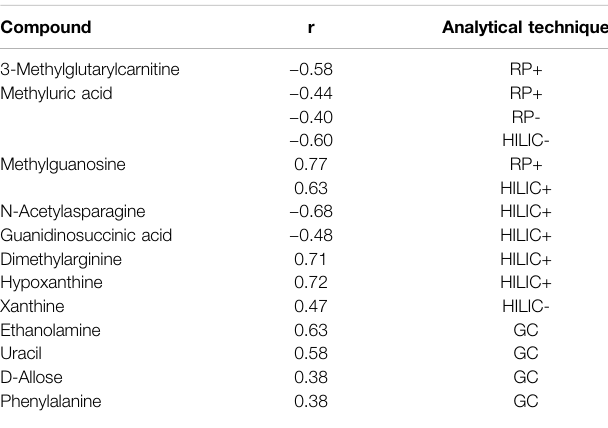
TABLE 4 | Metabolites with the highest correlation with eGFR value (Spearman ’ s rank correlation). Compound r Analytical